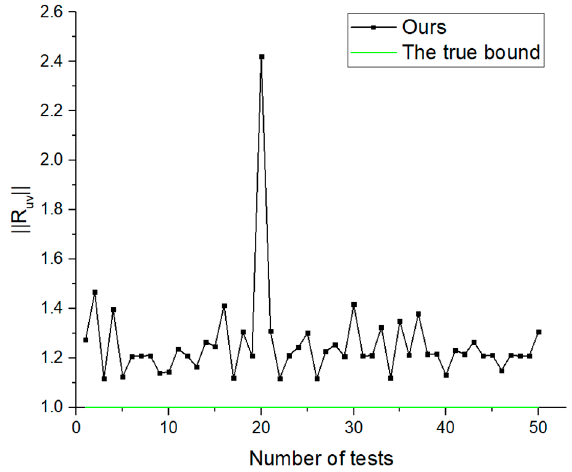
( ) R u of NURBS surfaces ( ) uv R u of NURBS surfaces uv